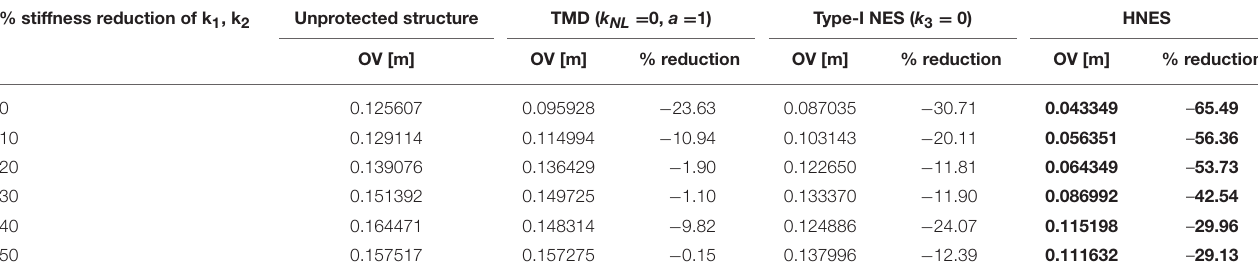
TABLE 4 | Objective values (OV) of max